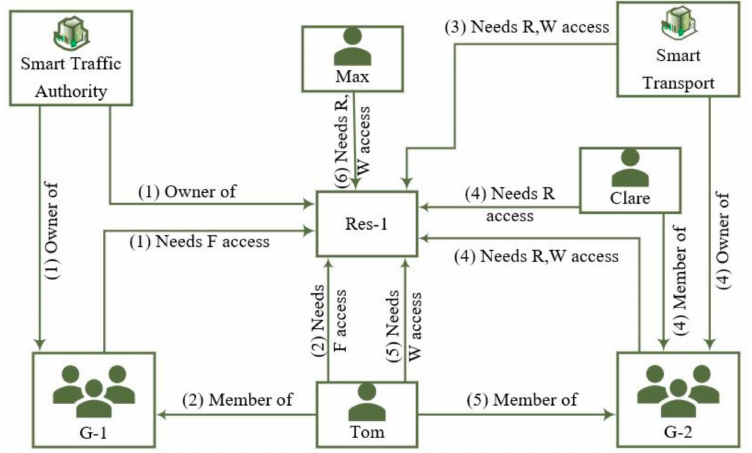
Figure 1. A complex AC use case in a smart city.